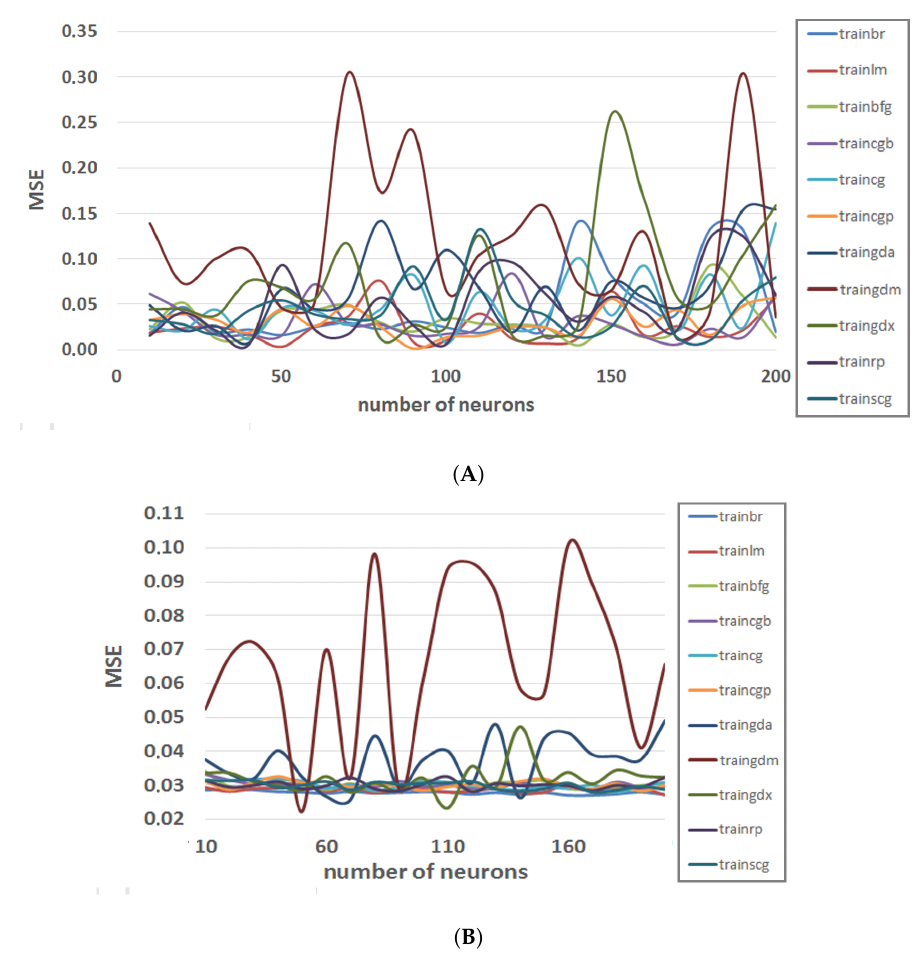
Figure 6. MSE for ANN’s verification for different learning methods and number on neurons in the hidden layer for wax materials: ( A )—beeswax, ( B